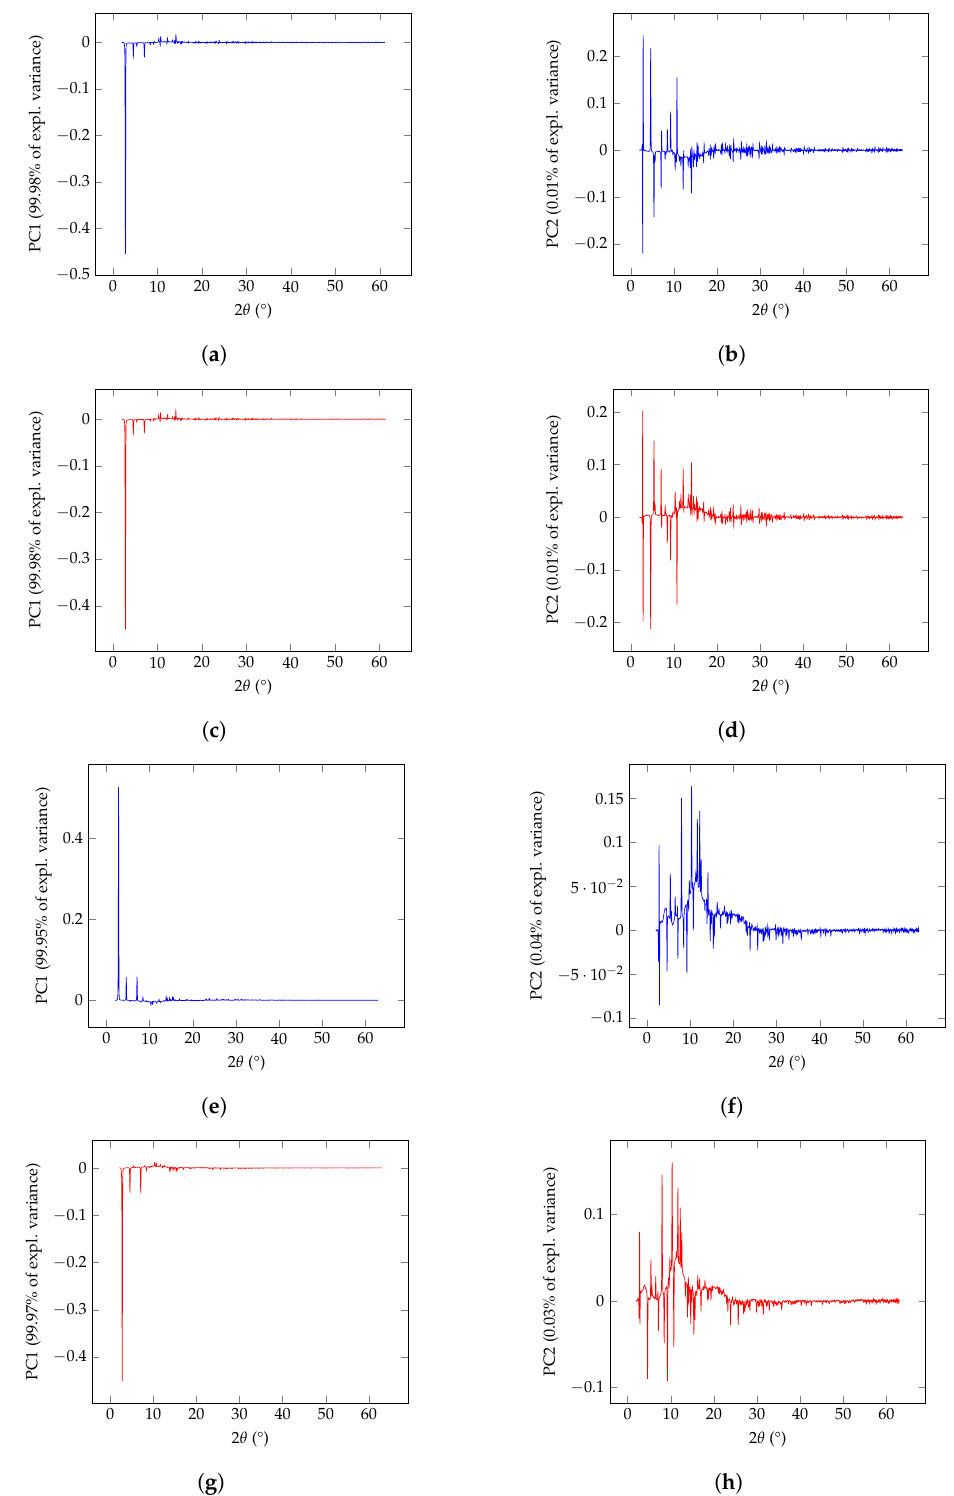
Figure 5. PC1 ( left ) and PC2 loadings ( right ) vs. 2 θ during ramp down (blue) and up (red) within CO 2 (top four) and Xe (bottom four) adsorption. ( a ) Ramped-down CO 2 loadings of PC1 vs. 2 θ . ( b ) Ramped-down CO 2 loadings of PC2 vs. 2 θ . ( c ) Ramped-up CO 2 loadings of PC1 vs. 2 θ . ( d ) Ramped-up CO 2 loadings of PC2 vs. 2 θ . ( e ) Ramped-down Xe loadings of PC1 vs. 2 θ . ( f ) Ramped-down Xe loadings of PC2 vs. 2 θ . ( g ) Ramped-up Xe loadings of PC1 vs. 2 θ . ( h ) Ramped-up Xe loadings of PC2 vs. 2 θ .